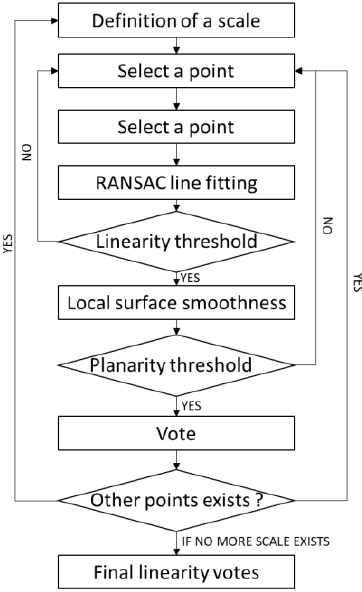
Figure 2. Workflow for multiscale linearity voting.